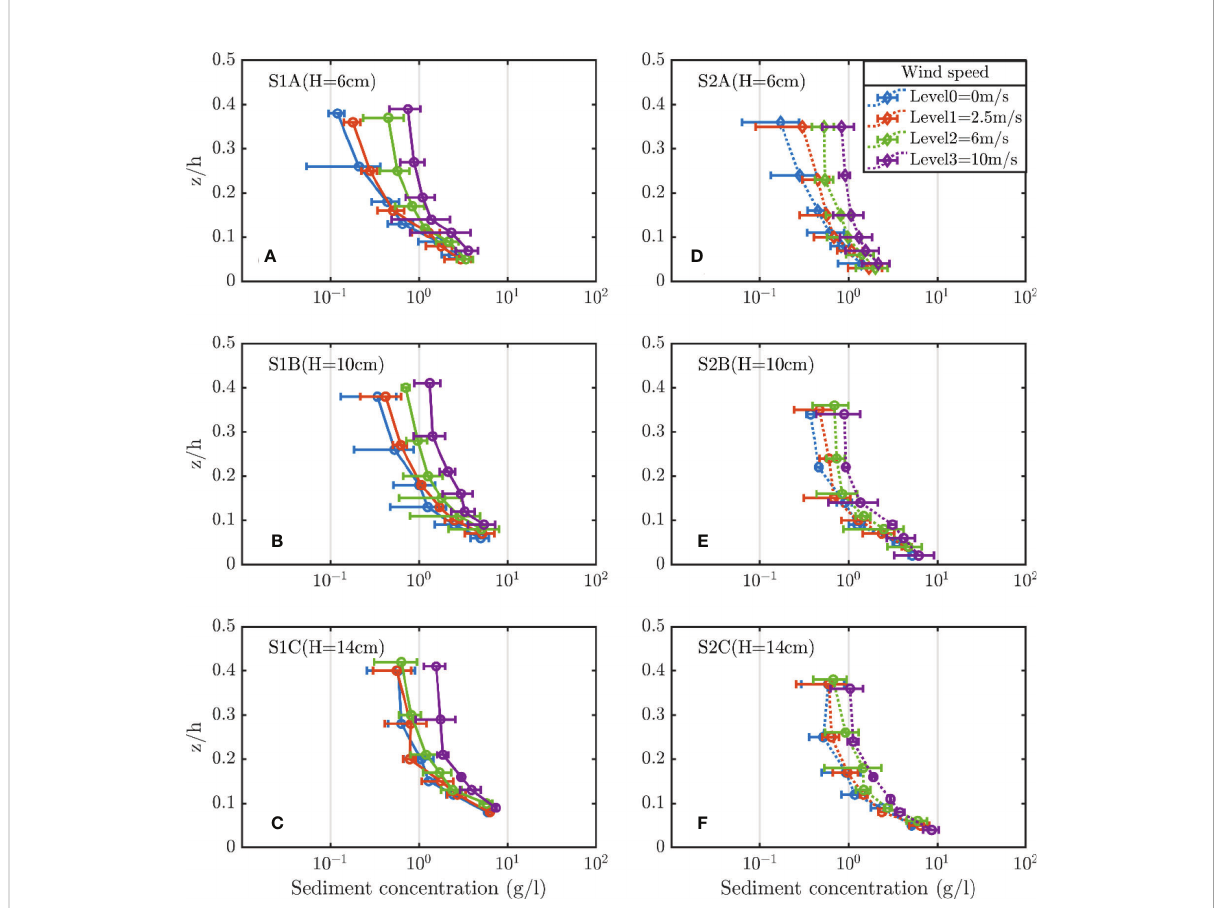
FIGURE 4 Vertical concentration pro fi les of S1 (solid lines, A – C ) and S2 (dashed lines, D – F ). Lines of different colors represent waves combined with the wind of various strengths. The capital letters in the upper left of each graph represent the sediment type and the experimental case. Bars are ensemble standard